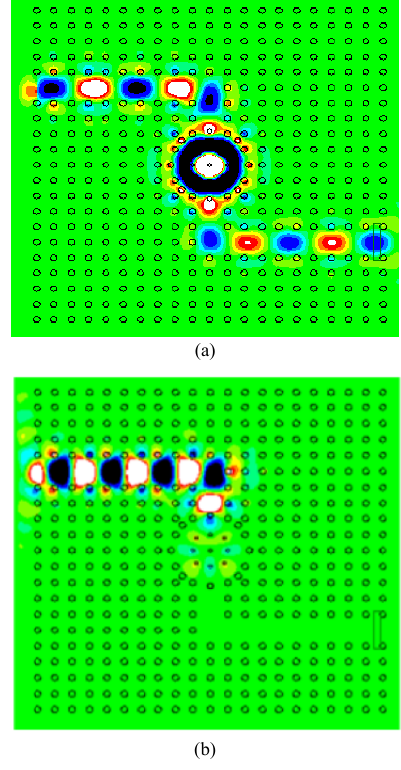
Fig. 5 Field distribution of the propose sensor at (a) ON resonance and (b) OFF